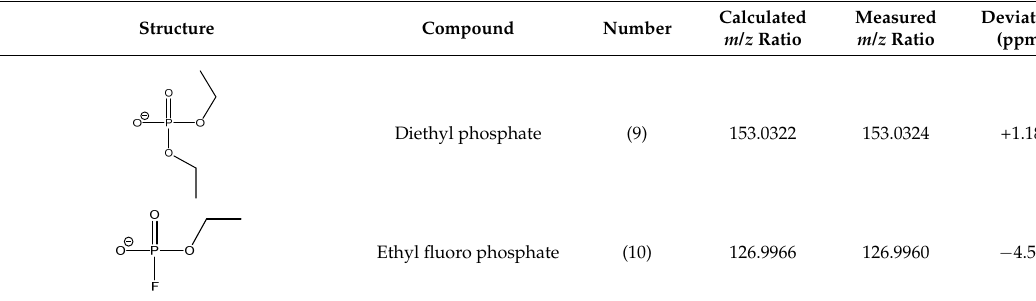
Figure 5. Electropherogram of the organophosphates (OPs) in the aged electrolyte sample containing dimethyl phosphate (DMP) and 1,3 ‐ propane sultone (PS).